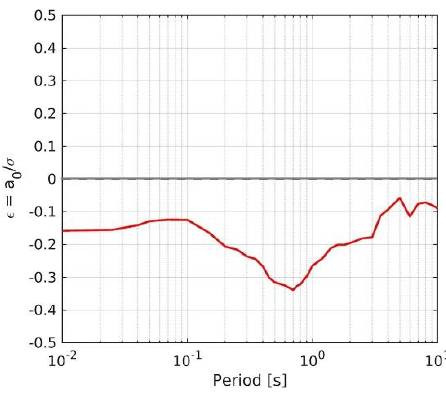
Figure 2. offset term a 0 , normalized for the total standard deviation of the ITACAext residuals. Figure 2. Offset term a 0 , normalized for the total standard deviation of the ITACAext